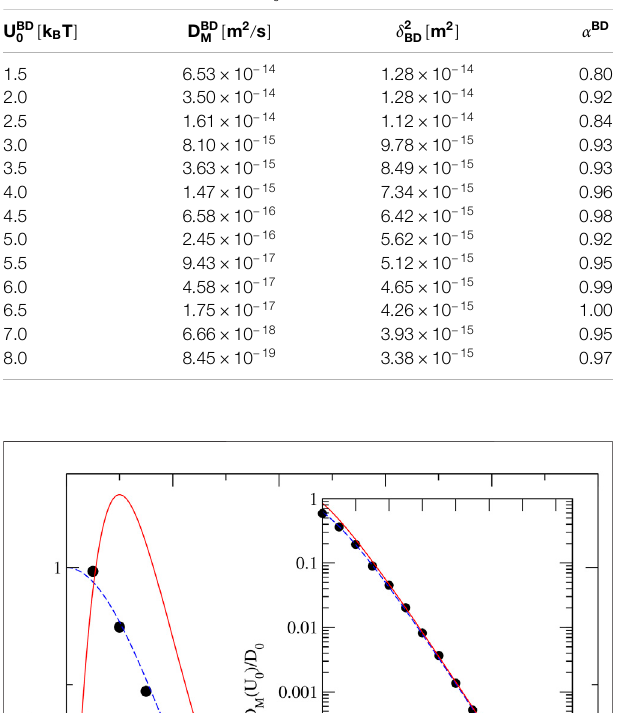
TABLE 1 | Bellour fi tting parameters D BD M , δ 2 BD , and α BD associated to the Brownian dynamicsmean square displacement curvesdisplayed in Figure 6 , as a function of the maximum height barrier U BD 0 . In all Brownian dynamics simulations, L (cid:2) 1 . 0 × 10 − 6 m and D BD 0 (cid:2) D 0 (cid:2) 1 . 8 × 10 − 13 m 2 / s .